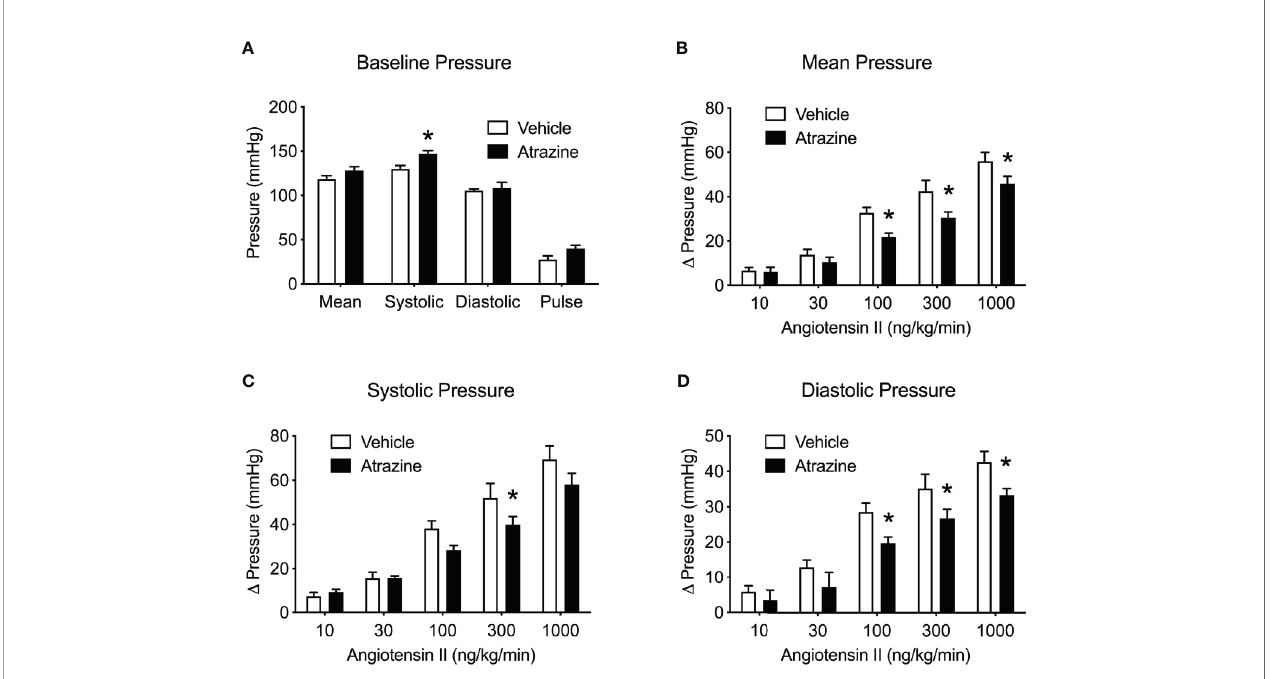
FIGURE 5 | Atrazine treatment alters basal arterial pressure and attenuates pressor effects of Ang II infusion. Histograms depicting the baseline blood pressure (A) in vehicle and atrazine (100 mg/kg) treated animals and changes in mean (B) , systolic (C) and diastolic (D) pressures in vehicle or atrazine treated animals during angiotensin infusion (10-1000 ng/kg/min). Data presented as the mean ± SEM. Asterisk signi fi es difference from control group ( P < 0.05).